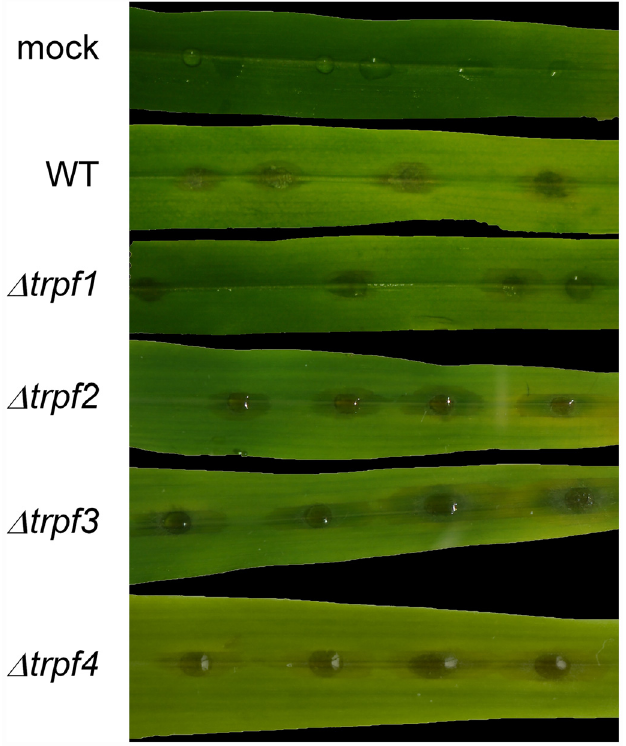
Fig 10. Detached-leaf infection assay. Sections of the third leaf of two-week-old maize plants (cv. Golden Jubilee) were infected with 10 4 spores of C . graminicola wild type or Cgtrpf1 through 4 deletion mutants per 10- μ L drop, or mock-infected with 10 μ L of 0.02% Tween 20 in bidistilled water. Representative images of three biological replicates are shown; the experiment was repeated twice with similar